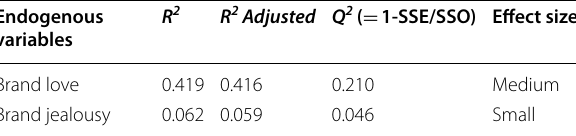
Table 5 Results of R 2 and Q